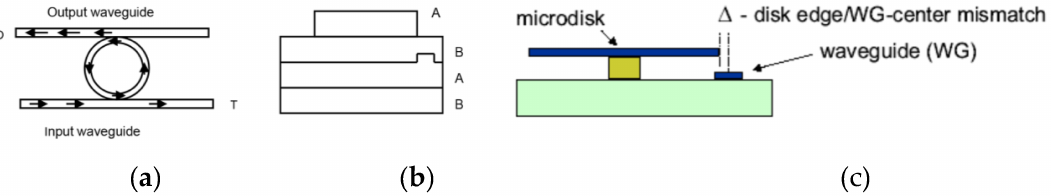
Figure 4. Sketch of the two basic geometries for optically-integrated WGM sensors: ( a ) top view of a microring with two port waveguides: O, output port; I, input port; T, through port; ( b ) cross-section of a microdisk with vertical coupling with a buried waveguide (A Si 3 N 4 layer, B SiO 2 layer); ( c ) cross-section of a microdisk with vertical coupling, non-buried waveguide.